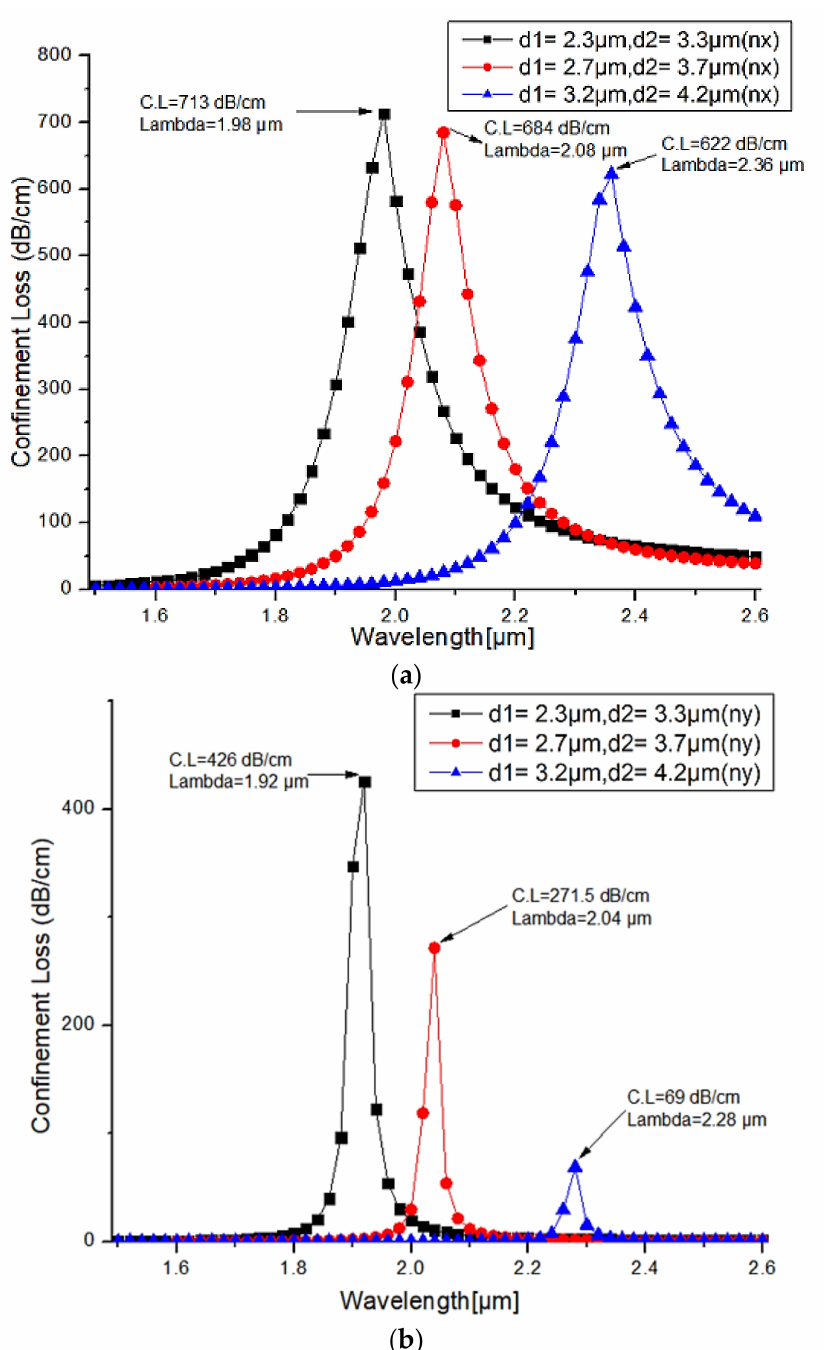
Figure 4. Confinement loss for the different pitch values ( a ) X-polarized mode ( b ) Y-polarized